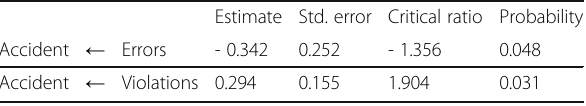
Estimate Std. error Critical ratio Probability